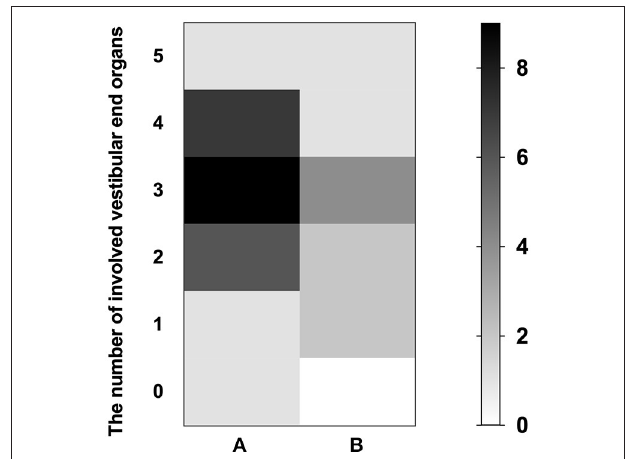
FIGURE 5 | The number of patients with involved vestibular end organs (VEOs) in the subgroup of profound SSNHL patients with vertigo group (A) and without vertigo (B) . The left ordinate represents the number of involved VEOs; the vertical axis on the right represents the number of